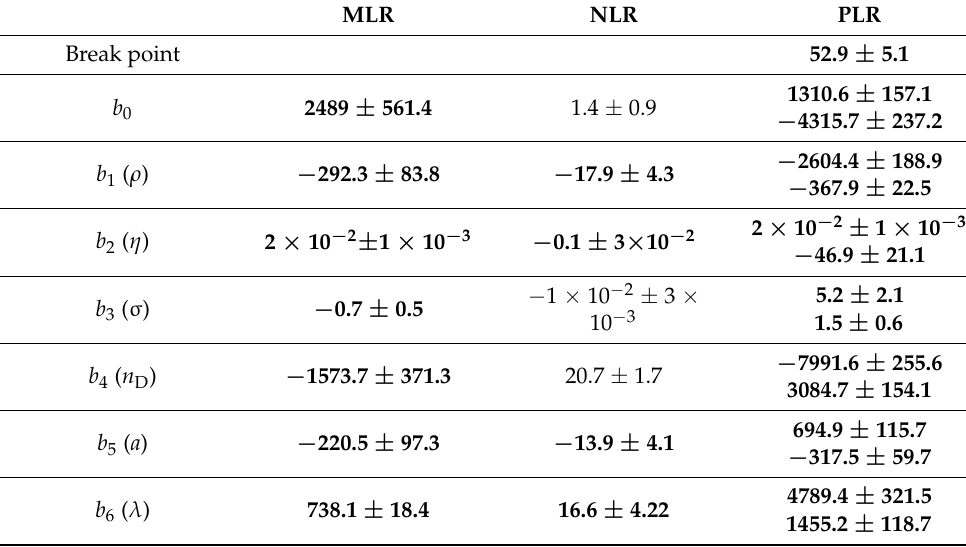
Table 5. MLR, NLR and PLR coefficients for prediction of extraction efficiencies based on DESs physical properties (significant coefficients for p < 0.05 are marked